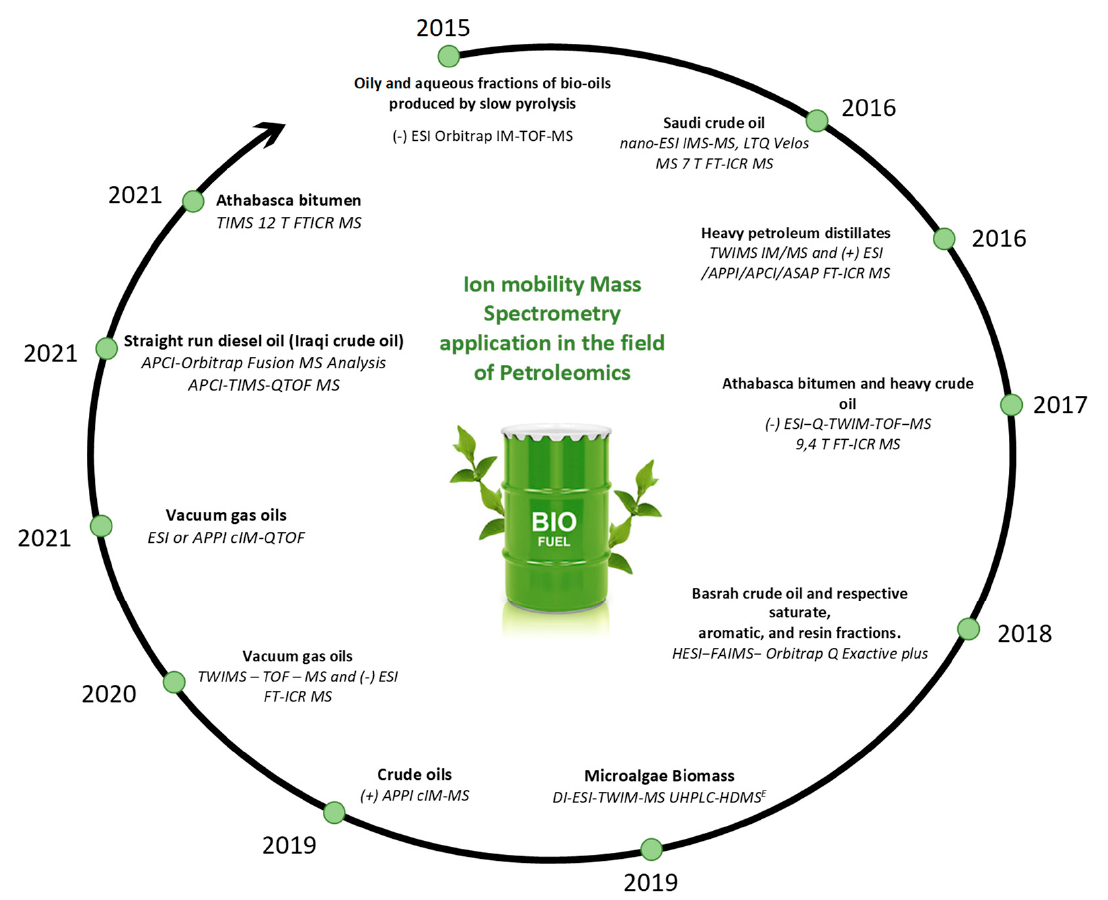
Figure 6. Main publications of IM-MS petroleomics [105,110–119].